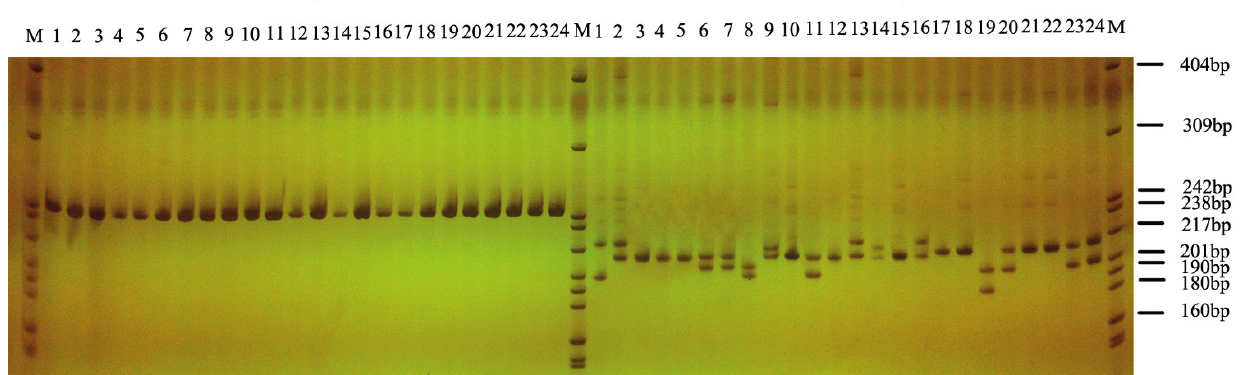
Figure 7. The results of the SSR-PCR that produced clear bands. M refers to DNA markers pBR322 DNA/MspI. Numbers 1 to 24 represent twenty-four individuals of T. sinensis. The products of primer TS061 are single bands without polymorphism, while those of TS062 are clear polymorphic